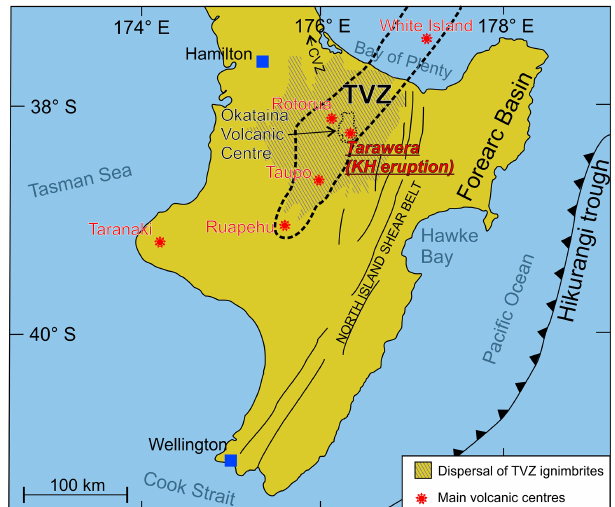
Figure 3. Tectonic environment of the TVZ (Taupo Volcanic Zone) and the main volcanic centers, including the Tarawera silicic dome complex, where the AD1314 Kaharoa eruption occurred. The main structural lines (solid line) are indicated. CVZ: Coroman- del Volcanic Zone. Modified after Graham et al. (1995), Briggs et al. (2005), and Kósik (2018).